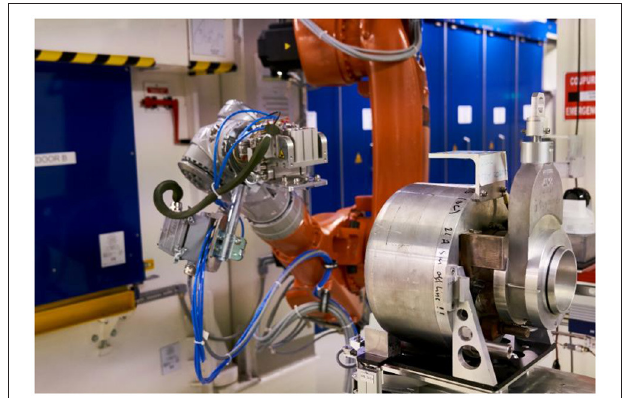
FIGURE 2 | The MEDICIS robot about to transfer a target from the RCS to the target station.